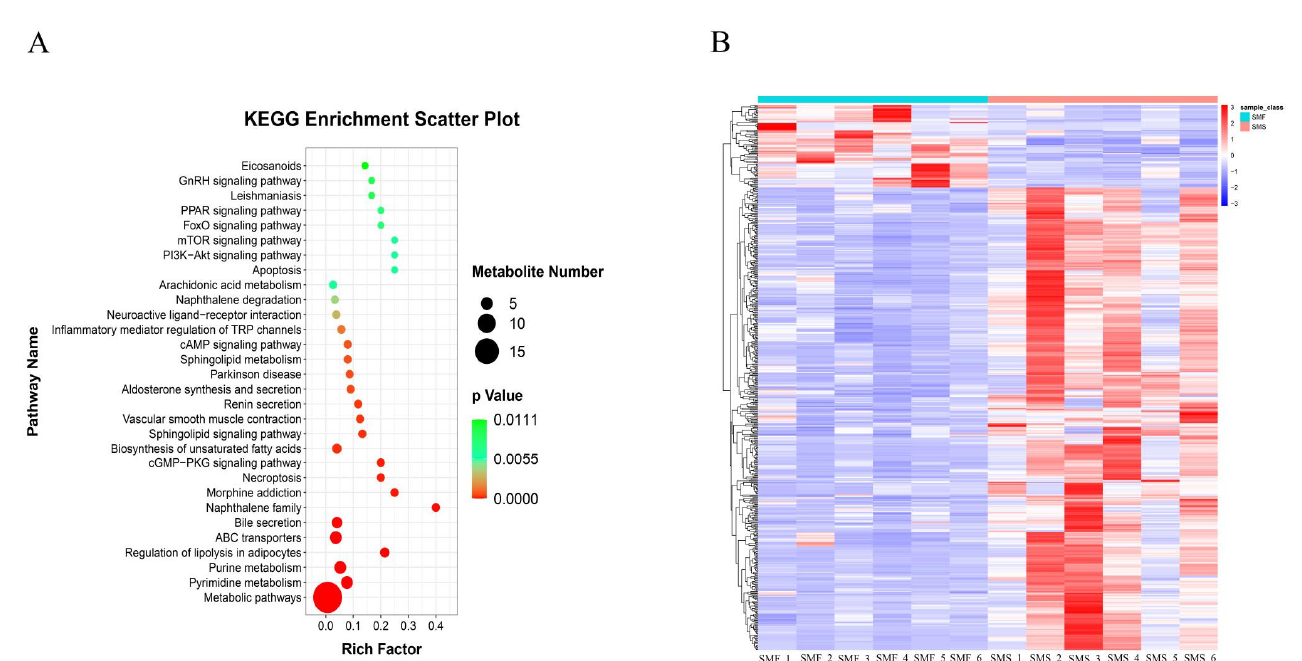
Figure 3. Hierarchical clustering analysis for DMs and the metabolomics view map of the significant metabolic pathways. ( A ) KEGG pathway analysis of metabolites differentially expressed between the SMF group and the SMS group. The vertical coordinates indicate the top 30 KEGG terms significantly enriched by DEMs and the horizontal coordinates indicate the enrichment factor between the two sampled datasets. ( B ) Hierarchical clustering analysis of DMs between SMF and SMS groups. Red indicates metabolites up-regulated in SMF; blue indicates metabolites up-regulated in SMS.